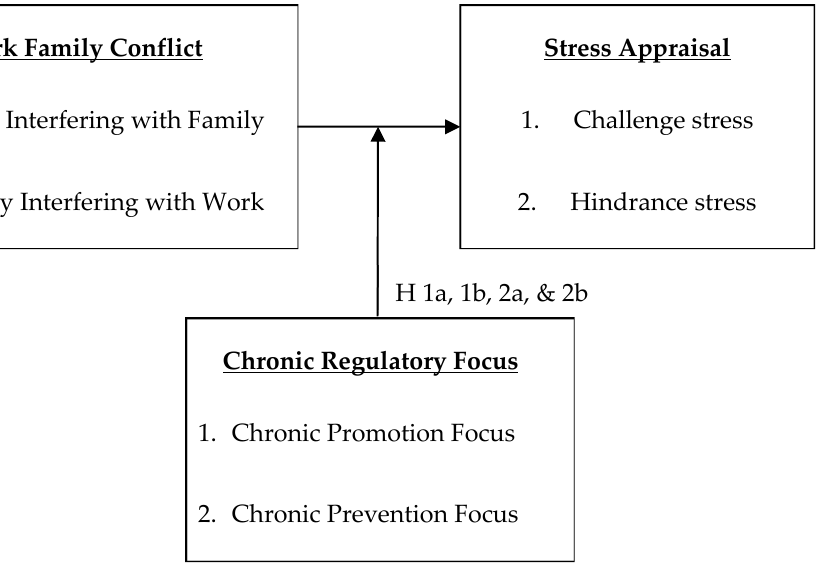
Figure 1. The conceptual model. H = Hypothesis.